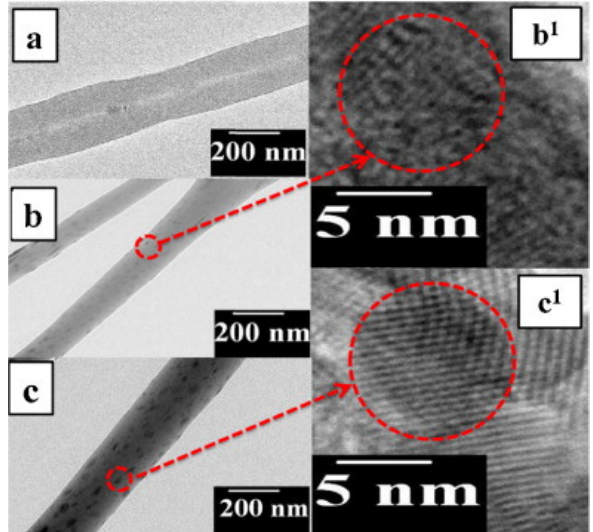
Figure 5. TEM images of ( a ) pristine PVAc electrospun nanofibers, ( b ) ZnS–PVAc hybrid electrospun nanofibers, ( c ) PdSZnS–PVAc hybrid electrospun nanofibers, and ( b1 , c1 ) HRTEM for the marked area in ( b , c ) hybrid electrospun nanofiber mats, respectively. (Reprinted from the work of Panthi et al. [32], Copyright 2015, with permission from Elsevier).